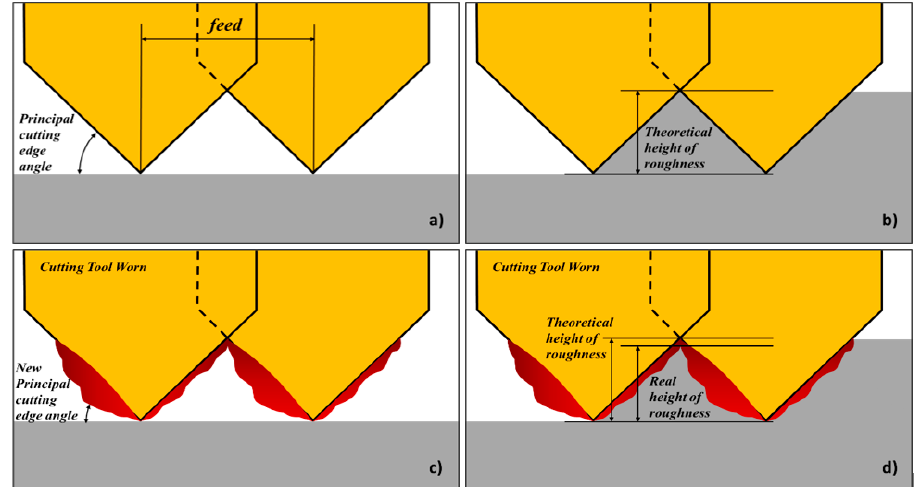
Figure 12. Tool wear effect on the surface roughness. ( a ) Initial cutting scheme. ( b ) Theoretical height of roughness during the machining process. ( c ) Cutting scheme with adhesion wear effects. ( d ) Reduction on roughness due to adhesion in flank face.